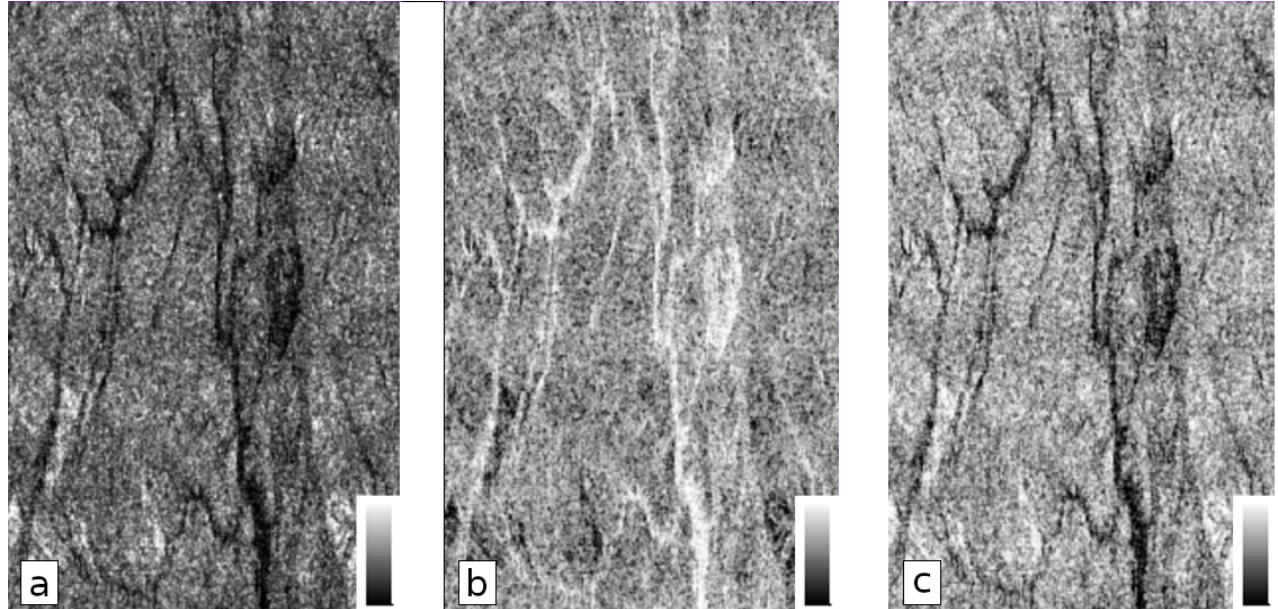
Figure 8. Results after polarimetric decomposition; ( a ) entropy (P, polarimetric), ( b ) anisotropy, and ( c ) alpha